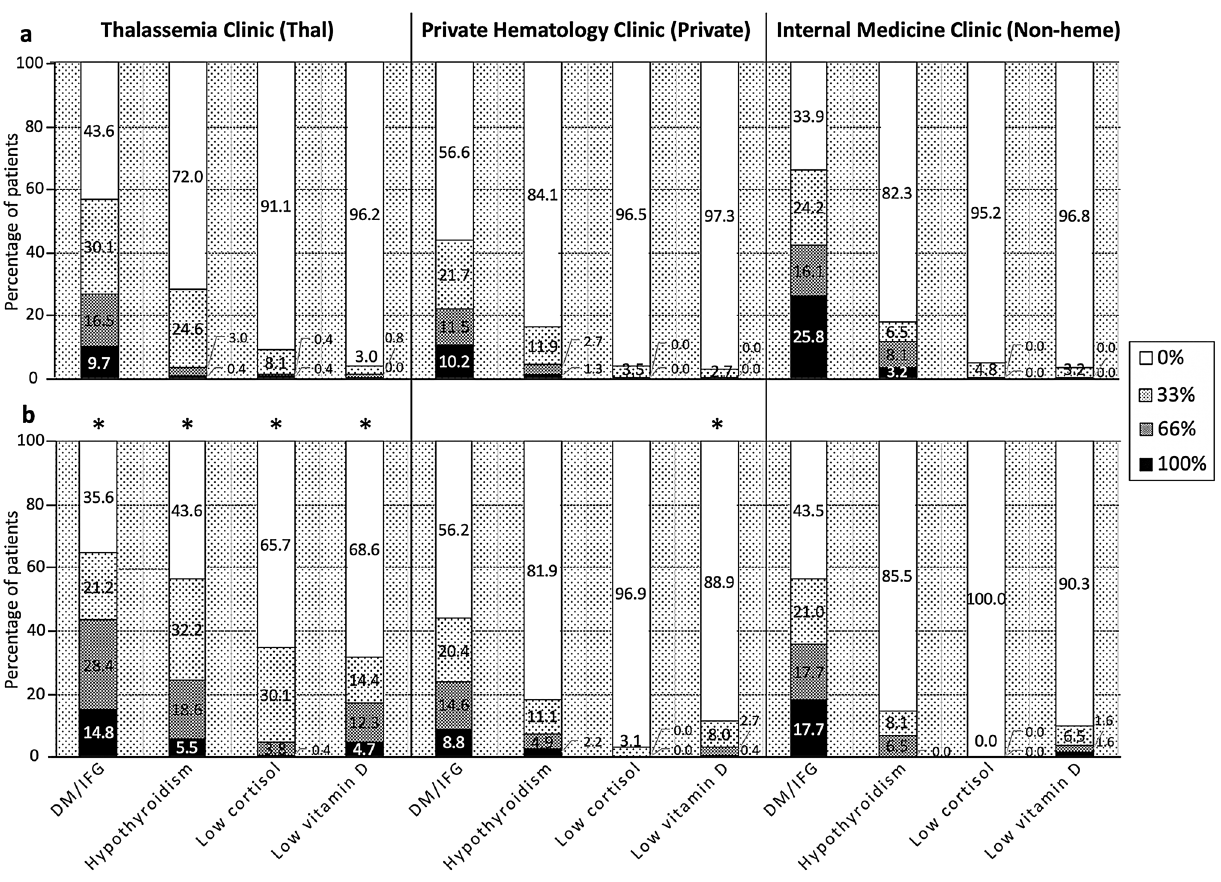
Figure 2. Comparing the frequency of yearly monitoring for thalassemia related complications; none (0%), one time (33%), 2 times (66%) and 3 times (100%) during three-year-period before CPG (2012–2014) ( a ) and after CPG (2015–2017) ( b ) by three different physician groups; thalassemia clinic, private hematology clinic, and non-hematology clinic. An asterisk indicates a significant difference between monitoring frequency before and after CPG ( p <